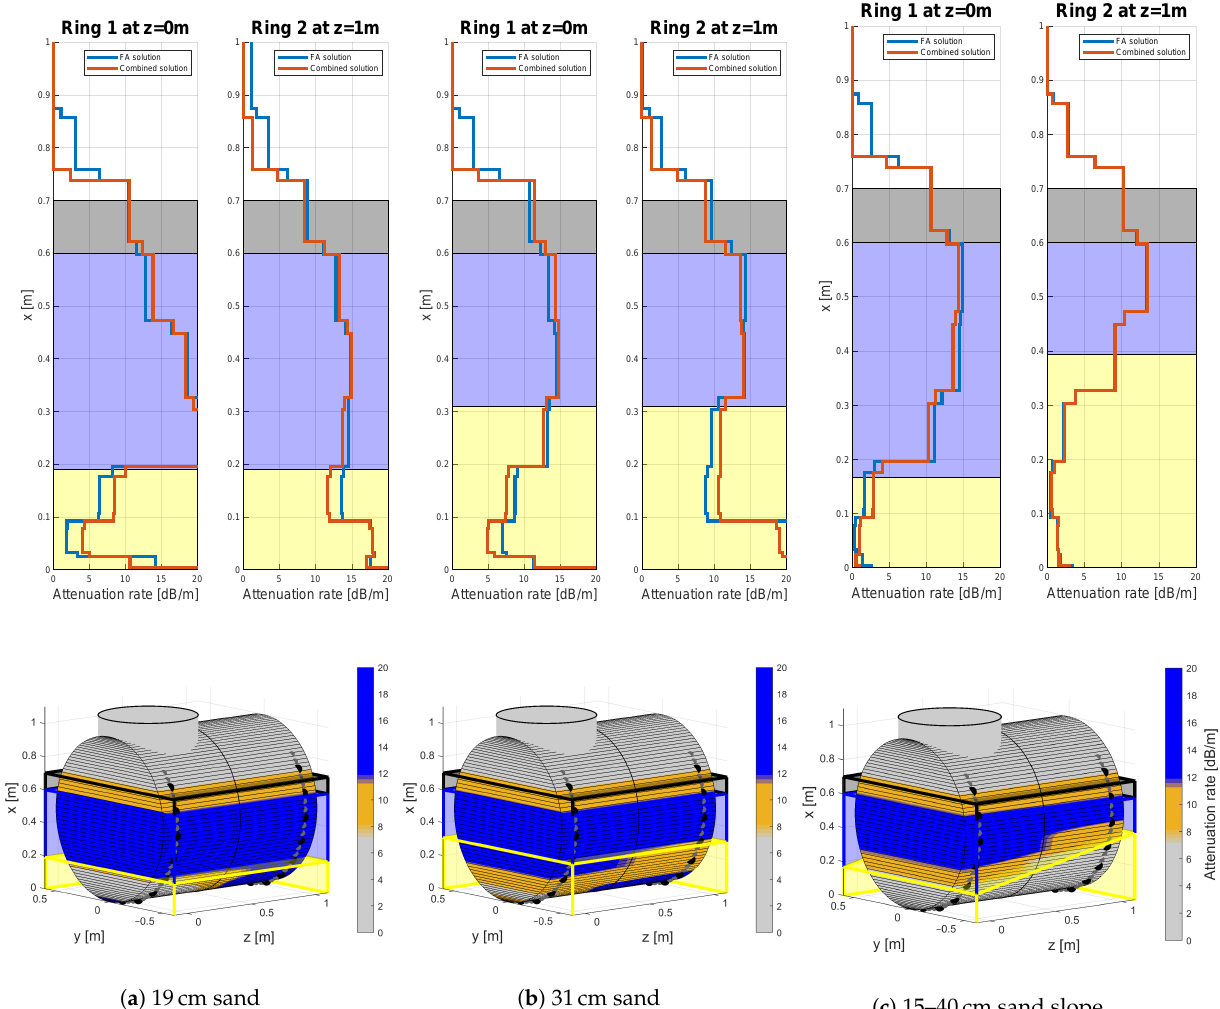
Figure 10. Results for three different sand fillings, 10cm oil, 60cm water, an excitation frequency of 100kHz and 15cm sensor